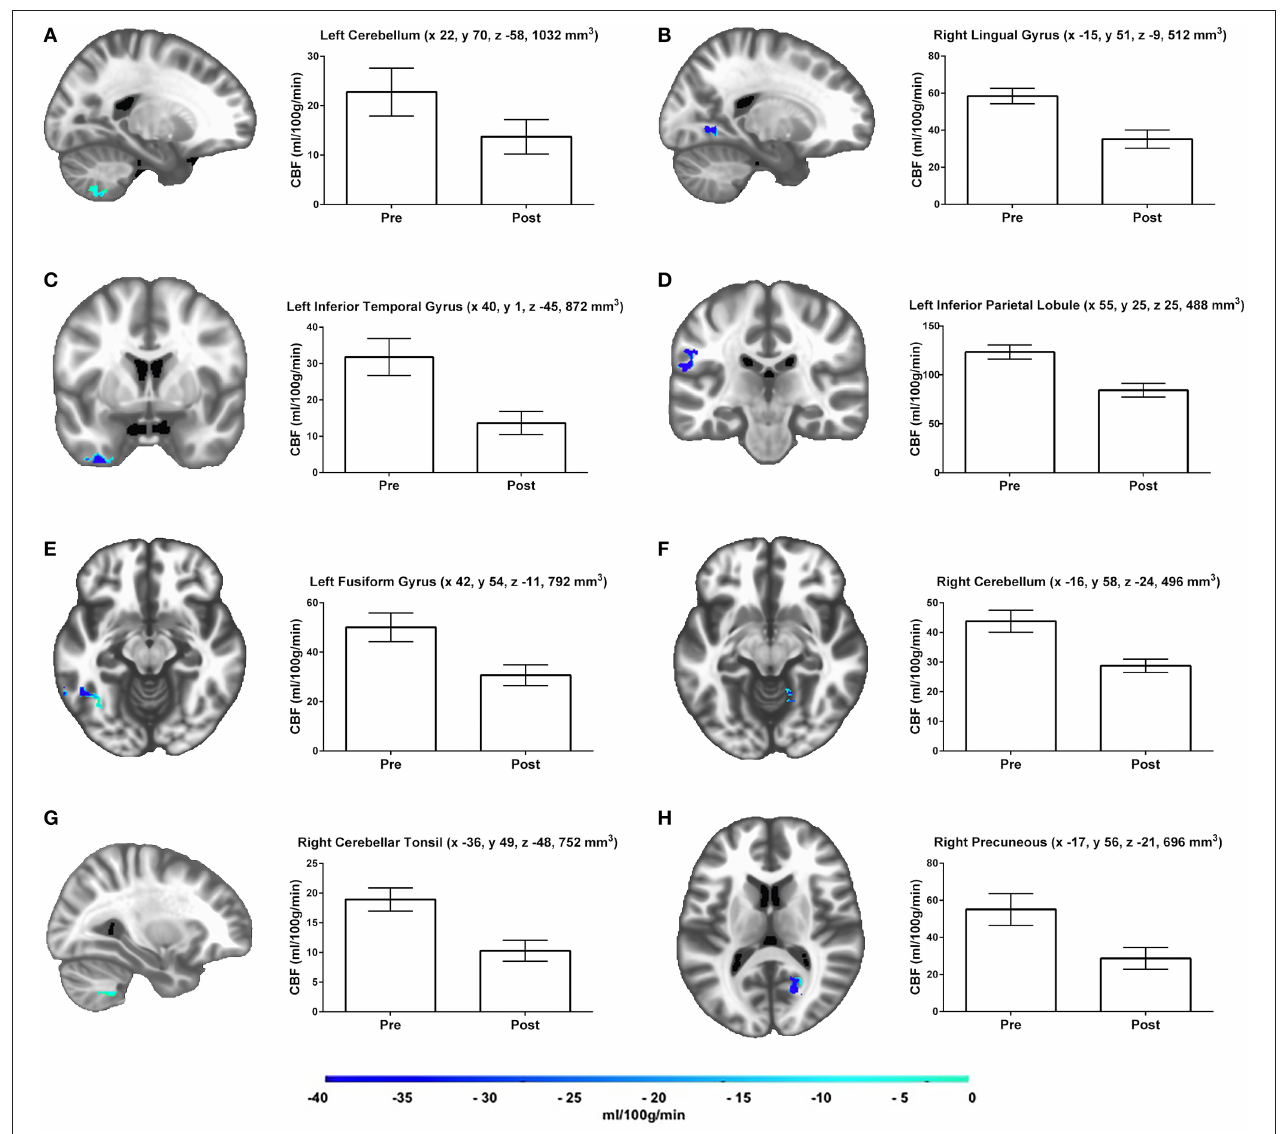
FIGURE 1 | Results of the gray matter voxel-wise analyses reveal eight brain regions (A–H), which demonstrated significant rCBF changes over time. Adjacent bar graphs represent the mean rCBF difference within each region, and include brain area, LPI coordinates, and cluster volume in mm 3 . The color bar represents the mean absolute CBF difference (post-detraining minus pre-detraining) within each region, expressed in ml/100g/min. Corrected p -values reflect the contrast between the Pre and Post time